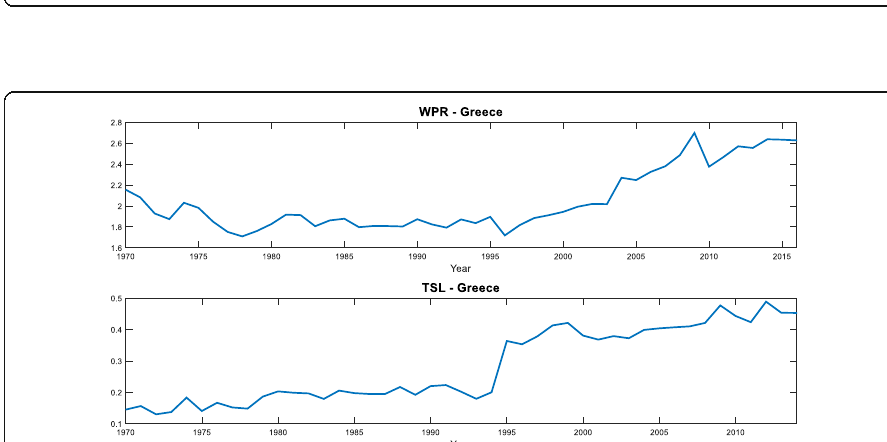
Fig. 14 Real per capita GDP in PPP values: Greece vs Euro Area. a Annual data over the period 1995 – 2014. b Per capita GDP is in constant 2010 prices and constant PPPs and has been detrended with the H-P filter with a smoothing parameter of 100. c Output gap is defined as the ratio of the HP filter cyclical component of real per capita output to the HP trend